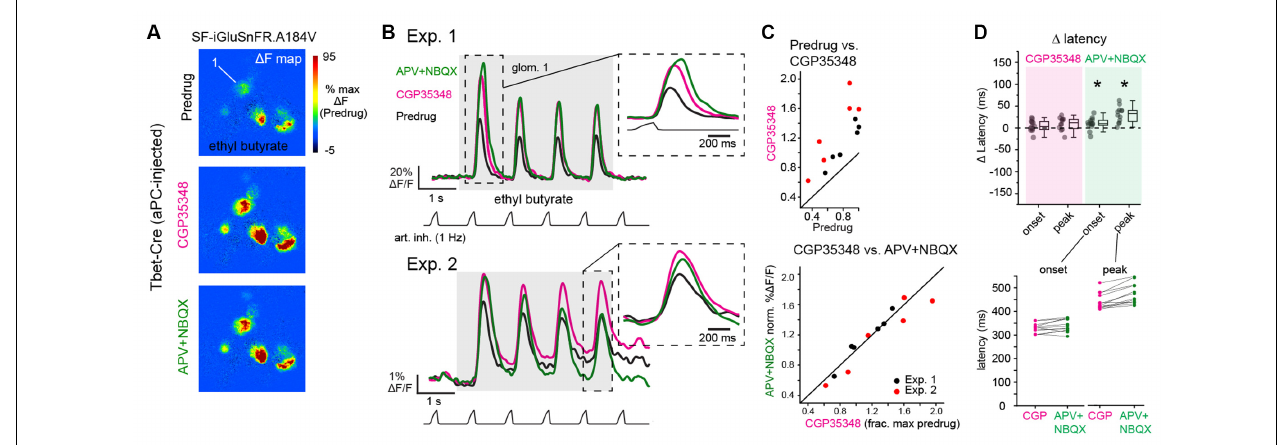
FIGURE 4 | Blockade of postsynaptic excitation does not impact the magnitude or latency of inhalation-linked glutamate signaling onto piriform-projecting mitral/tufted (pcMT) cells. (A) Odorant-evoked SF-iGluSnFR.A184V response maps across Predrug, CGP35348, and APV+NBQX conditions in an aPC-injected Tbet-Cre mouse. Maps are scaled to max of Predrug condition. (B) Top: Traces showing responses of ROI 1 (from A ) across conditions. Inhalation frequency, 1 Hz. inset shows the expansion of response to the first inhalation of odorant in each condition, showing a slight increase in latency to peak after APV+NBQX application. Bottom: Example traces from ROI in second preparation (Exp. 2, imaged with epifluorescence), showing similar drug effects, although with some change in tonic (non-inhalation-linked) signal. Inset shows expansion of response to the fourth inhalation, with traces shifted to start at same pre-inhalation baseline. Traces low-pass filtered at 5 Hz for display. (C) Comparison of peak SF-iGluSnFR.A184V responses (1st inhalation) across CGP35348 (left) and APV+NBQX (right) conditions. Points indicate glomeruli from two mice (red and black). for the two mice. Statistics for each of two experiments: CGP35348/Predrug ratios (mean ± SD, t-test compared to ratio of 1): Exp. 1, 1.35 ± 0.097, p = 5 × 10 − 4 , n = 6 glomeruli; Exp. 2, 1.90 ± 0.3, p = 1.6 × 10 − 3 , n = 6 glomeruli; APV+NBQX/CGP35348 ratios: Exp. 1, 1.02 ± 0.07, p = 0.94; Exp. 2, 0.91 ± 0.1, p = 0.2. (D) Little change in onset and peak latencies of SF-iGluSnFR.A184V response to the first inhalation of odorant after application of CGP35348 and APV+NBQX, for same glomeruli and animals as in (C) . Top: Change in onset or peak latency relative to pre-drug condition. Asterisks indicate a significant change in latency after drug treatment (see Text for statistics). Bottom: Absolute onset and peak latencies before (CGP) and after APV+NBQX application for each ROI. Latency measurements were pooled across the two experiments due to the lower number of ROIs supporting reliable